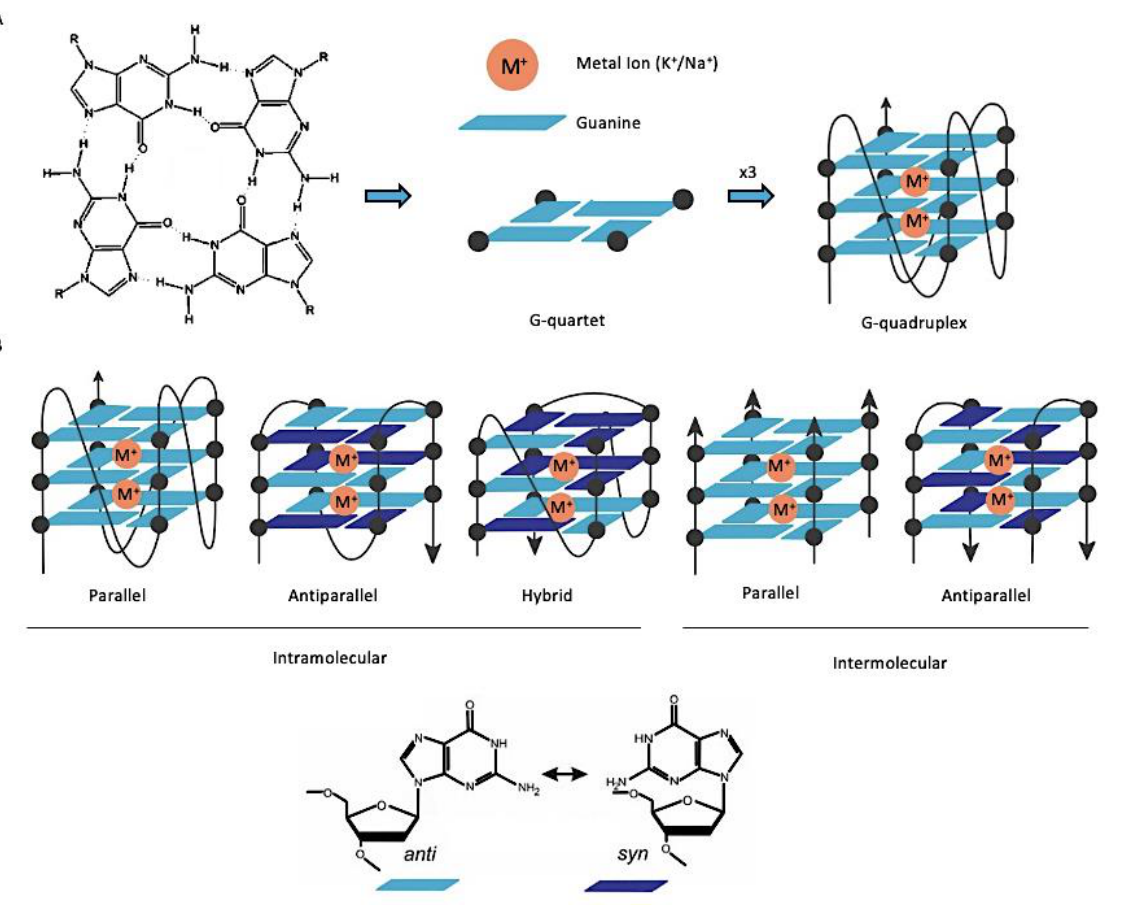
Figure 1. General structure and topologies of G-quadruplexes (G4). ( A ) Representation of a G-quartet stabilized by Hoogsteen hydrogen bonds ( left ). Schematic representation of a G-quadruplex additionally stabilized by π - π interactions and monovalent cations ( right ). ( B ) Schematic illustration of different intra- and intermolecular G4 topologies with different guanosine conformations ( syn and anti ).